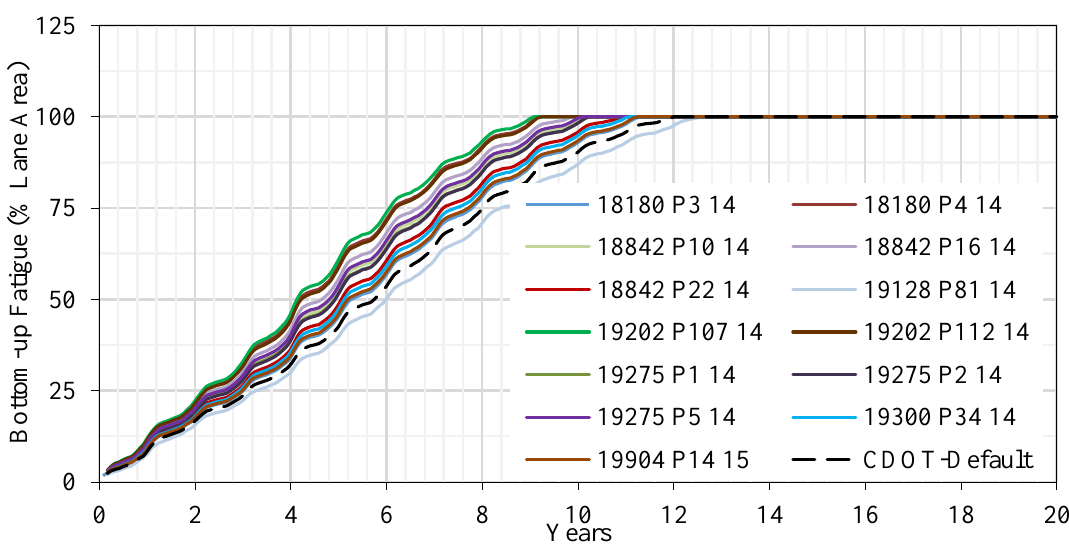
Figure 5. Bottom-up fatigue cracking due to AADTT = 7000 by SX (100) PG 64-22 mix. Designs 2019 , 3 , x FOR PEER REVIEW 10 of 12 Top-down Longitudinal Cracking: Figure 6 shows the top-down longitudinal cracking of the trial pavement with the service life of the pavement for AADTT = 7000. It shows that the prediction of top-down longitudinal cracking by the CDOT-default mix (except for 19128 P81 14) data is the lowest. This means that the CDOT-default dynamic modulus data for the PG 62-22 binder predicts lower top-down longitudinal cracking compared to that of the actual tested dynamic modulus (except 19128 P81 14). Mixes reach the threshold value of 400 m / km (2000 ft. / mi.) from three to eight years. The statistical analysis shows that none of the mixes (Figure 6) is within the 95% CI boundaries.